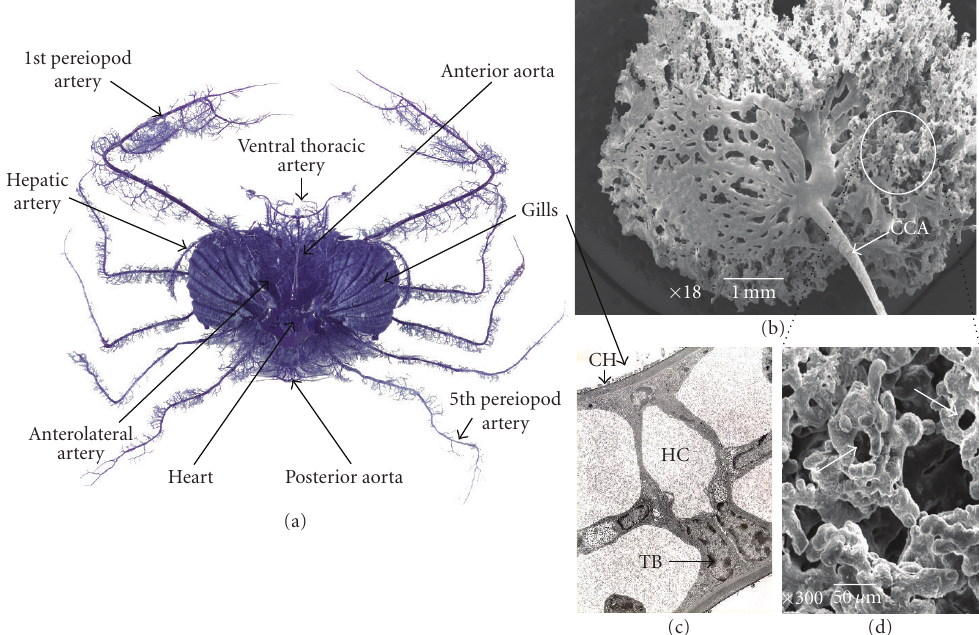
Figure 5: The cardiovascular system of decapod crustaceans is highly developed with a globular heart capable of delivering hemolymph at relatively high pressures and flows into capillary-like vessels supplying metabolically active tissues. This distribution system is dramatically illustrated (a) in a corrosion cast of the blue crab’s circulatory system. The complexity of the decapod crustacean vasculature is seen in a corrosion cast of the antennal gland ((b) from McGaw and Reiber [26]) and a highly magnified image of the capillary like vessels serving this structure (d) (CCA—coelomosac artery) [27]. A transmission electron micrograph of a cross-section through the gills also clearly shows well-defined hemolymph channels that maximize branchial exchange ((c) from McGaw and Reiber [26]) (CH—chitinous exchange surface of lamellae; HC—hemolymph channels; PC—pillar